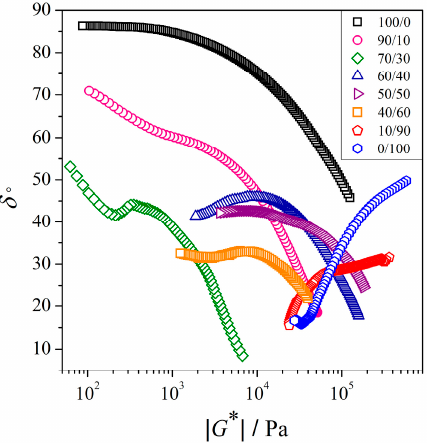
Figure 7. Van Gurp-Palmen plots of PEO/NR- g -PMMA blends at T = 140